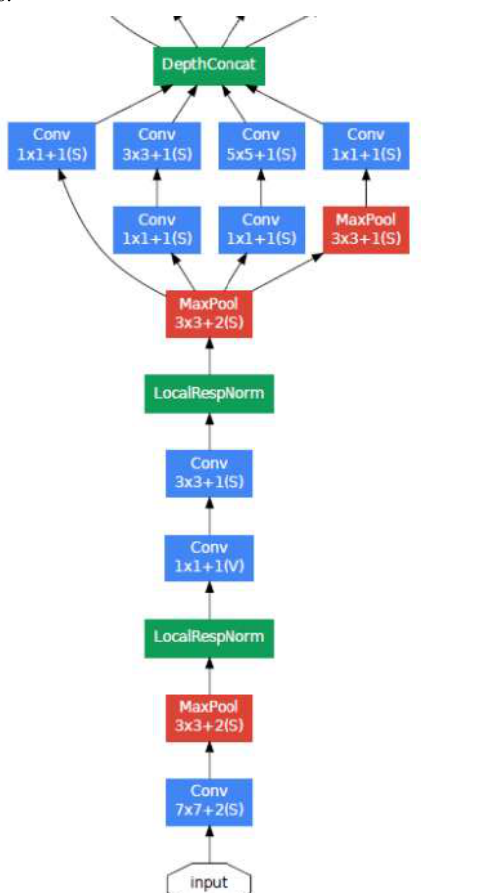
Fig. 7. Part of GoogleNet Deep Convolutional Neural Network